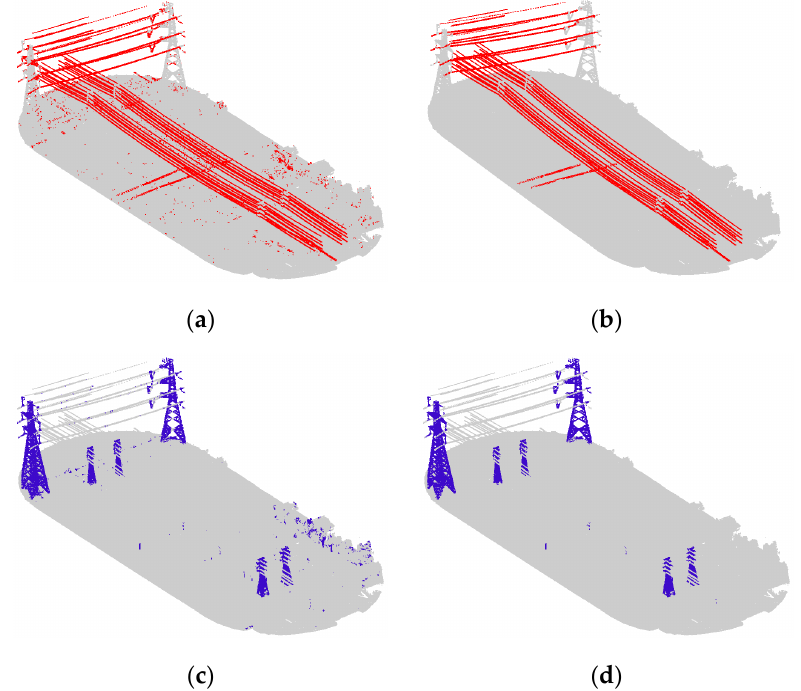
Figure 9. Classification results: ( a ) coarse result of power line; ( b ) fine result of power line; ( c ) coarse result of power tower; and ( d ) fine result of power tower.